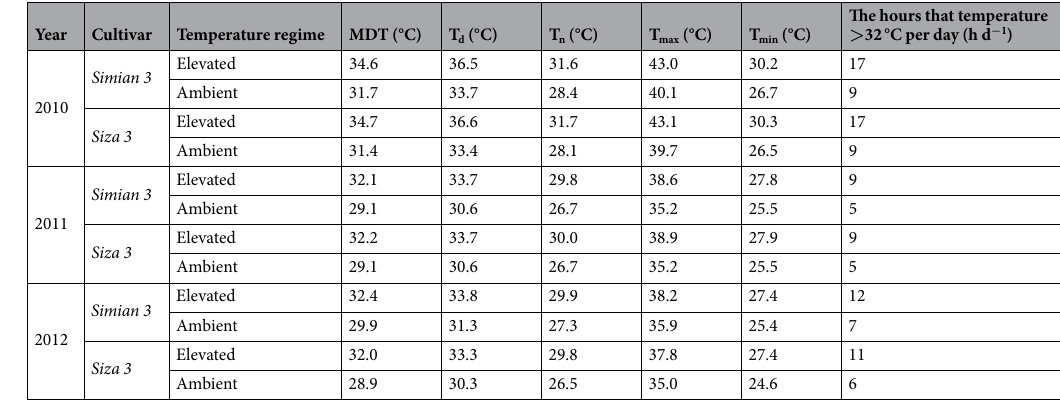
Table 1. Temperature indices during cotton fiber elongation in two temperature regimes from 2010 to 2012. MDT, Mean daily temperature; T d , mean daytime air temperature; T n , mean nighttime air temperature; T max , mean daily maximum air temperature; T min , mean daily minimum air temperature.